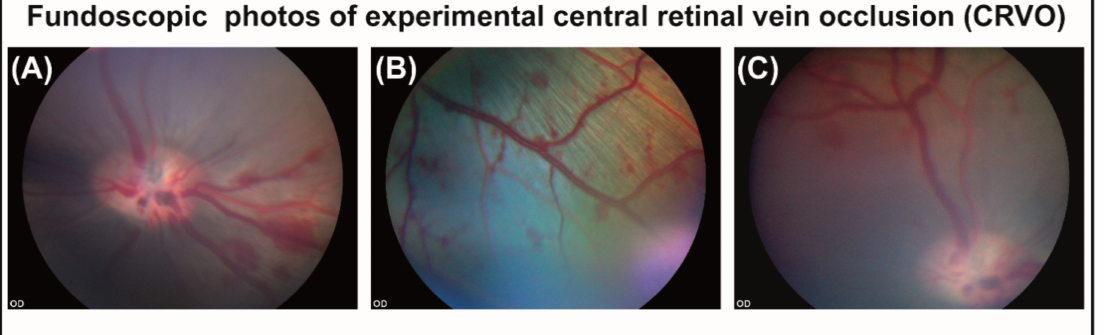
Figure 1. ( A ) Flame-shaped hemorrhages appearing in the retina within 30 min after CRVO. ( B ) Flame- shaped hemorrhages appearing upstream of the site of occlusion. ( C ) Dilated vein observed upstream of the site of